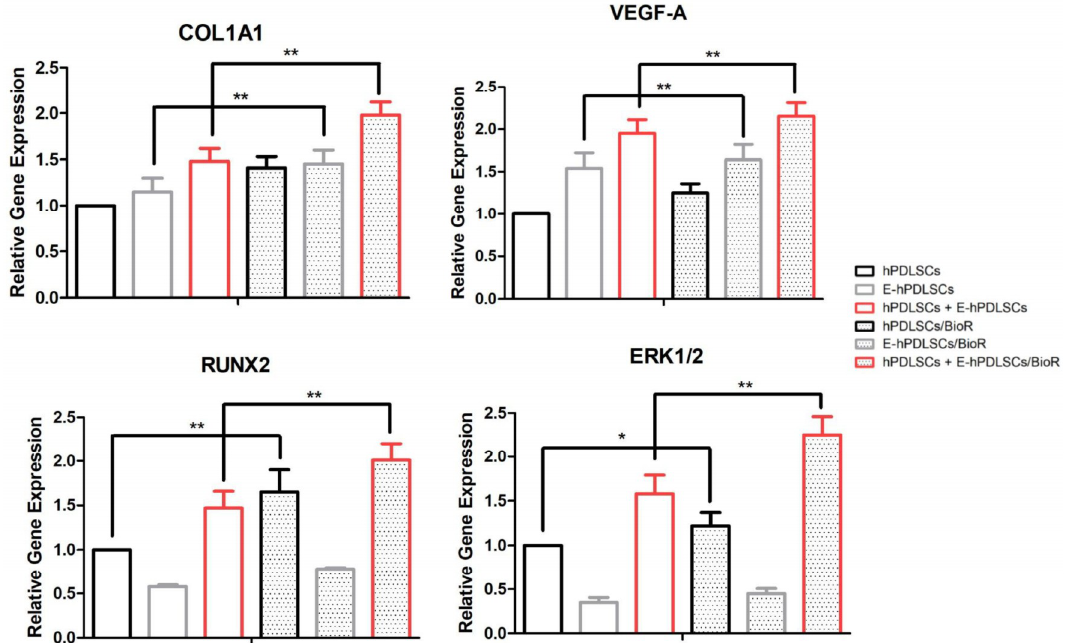
in hPDLSCs, E-hPDLSCs and hPDLSCs + E-hPDLSCs cultured with and without BioR. ** p < 0.01 and Figure 6. RT‐PCR. Graph bars showed the gene expression of COL1A1, VEGF‐A, RUNX2 and * p < ERK1/2 in hPDLSCs, E‐hPDLSCs and hPDLSCs + E‐hPDLSCs cultured with and without BioR. ** p < 0.01 and * p < 0.05.